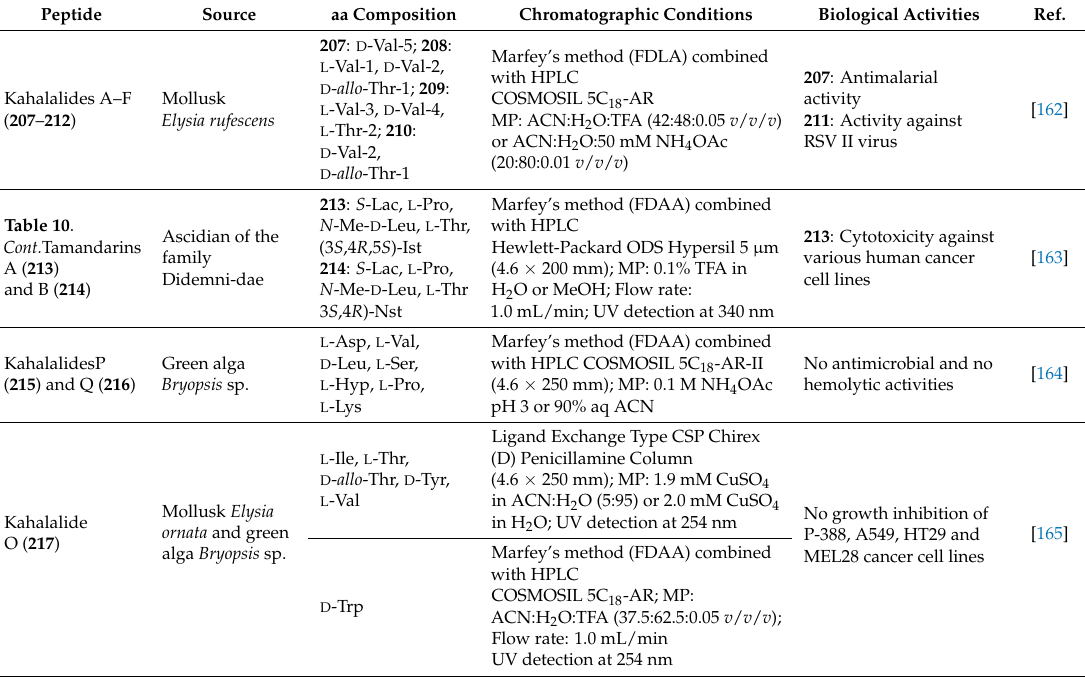
Table 10 . Table 10 . Cont.